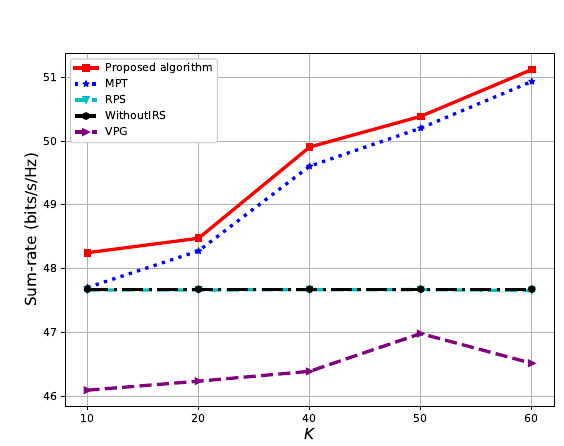
Figure 2. The network sum-rate versus the number of IRS elements, K .